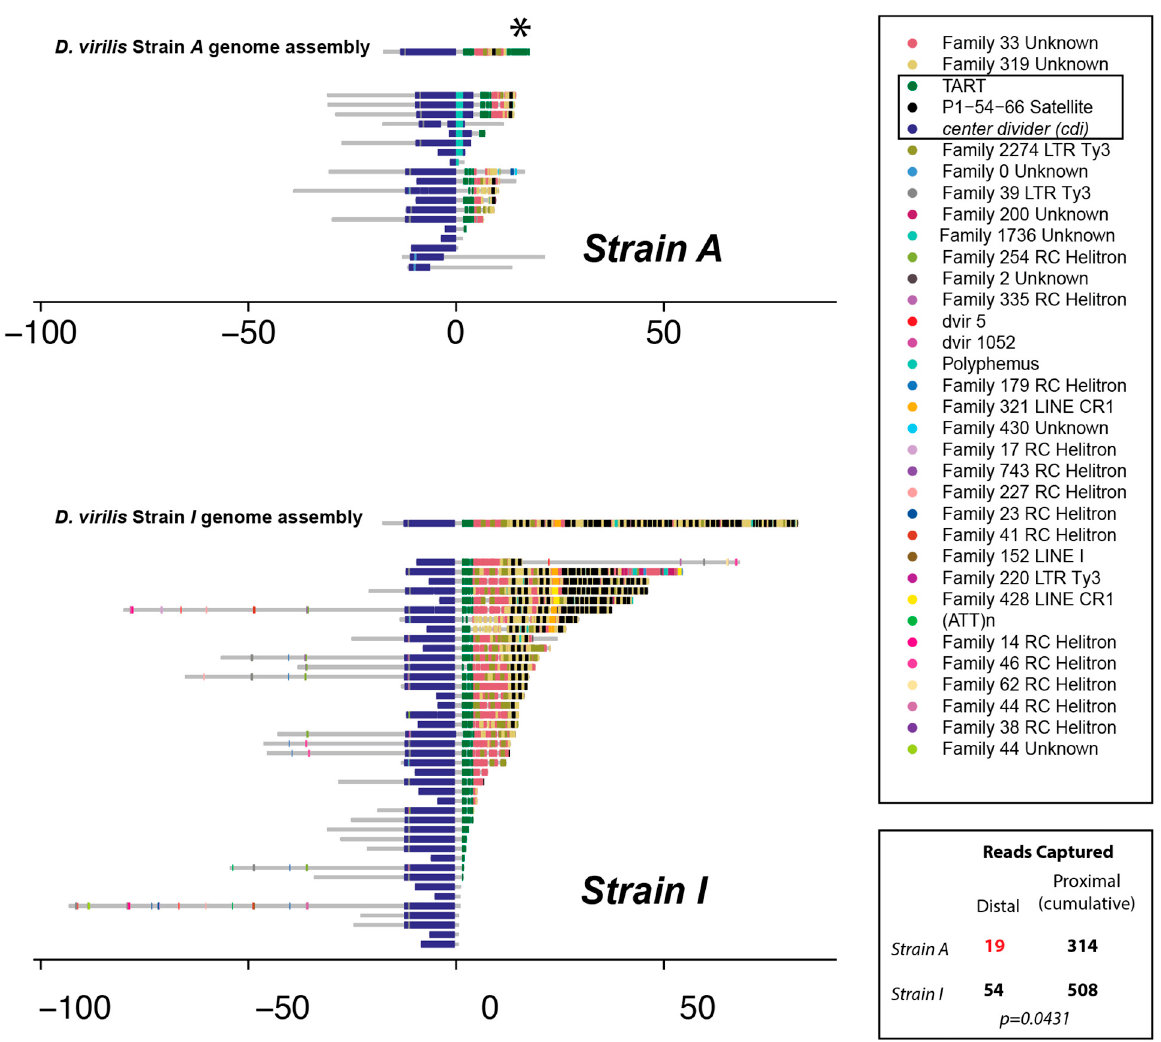
Figure 2. Repeat annotation of individual nanopore reads from Strain A and Strain I. The cdi gene sequence was used as a BLAST query for nanopore reads and reads carrying cdi along with further distal sequence were annotated with the new TE library and RepeatMasker. One read, a duplex read, was excluded from Strain A. Note the turquoise insertion of Polyphemus in some reads of Strain A. * indicates a fragment of TART that is likely an assembly artifact, but shown for completeness. Bottom right indicates results from nanopore read BLAST capture analysis. There is significant depletion of distal read coverage in the cdi A strain. This indicates a shorter telomere array.